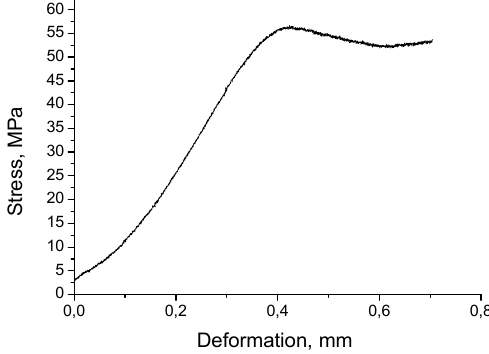
Figure 4. Typical curve of interlaminar shear strength (ILSS) tests.